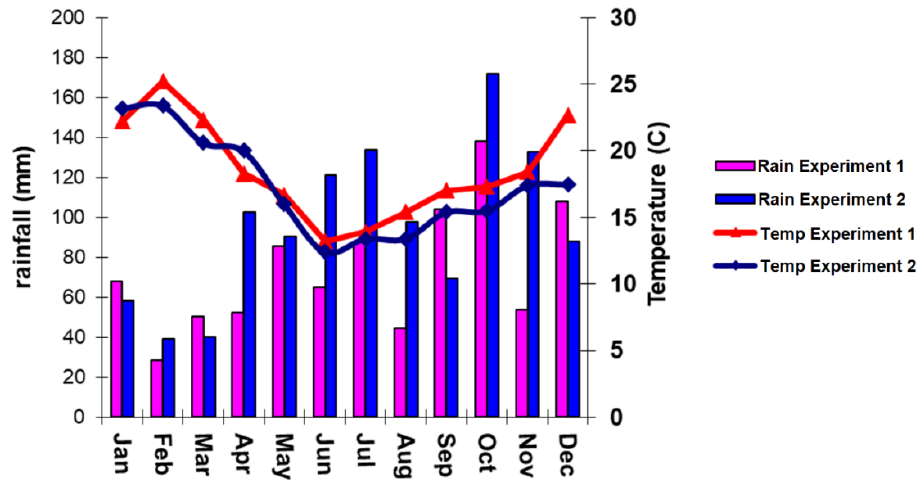
Figure 1. Total monthly rainfall (mm) and average maximum temperatures (°C) for the duration of the trial as measured at a weather station 1 km from the trial sites. Table 1. The herbicides and rates used for the